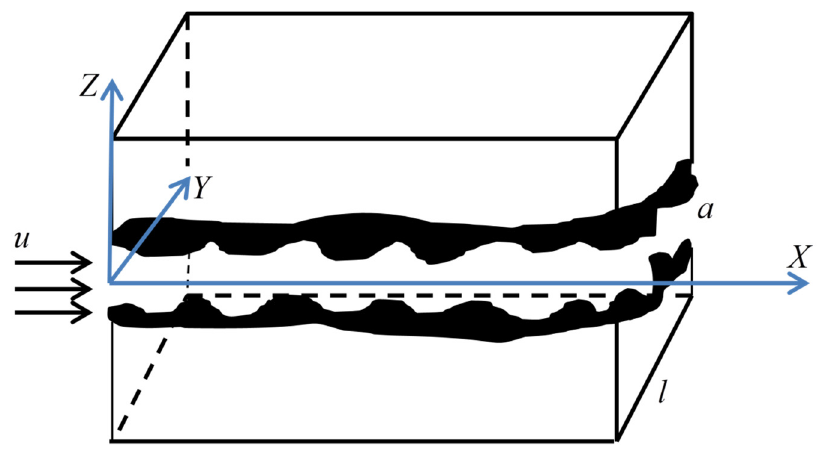
Figure 5. Spatial coordinates of horizontal rough fractures.